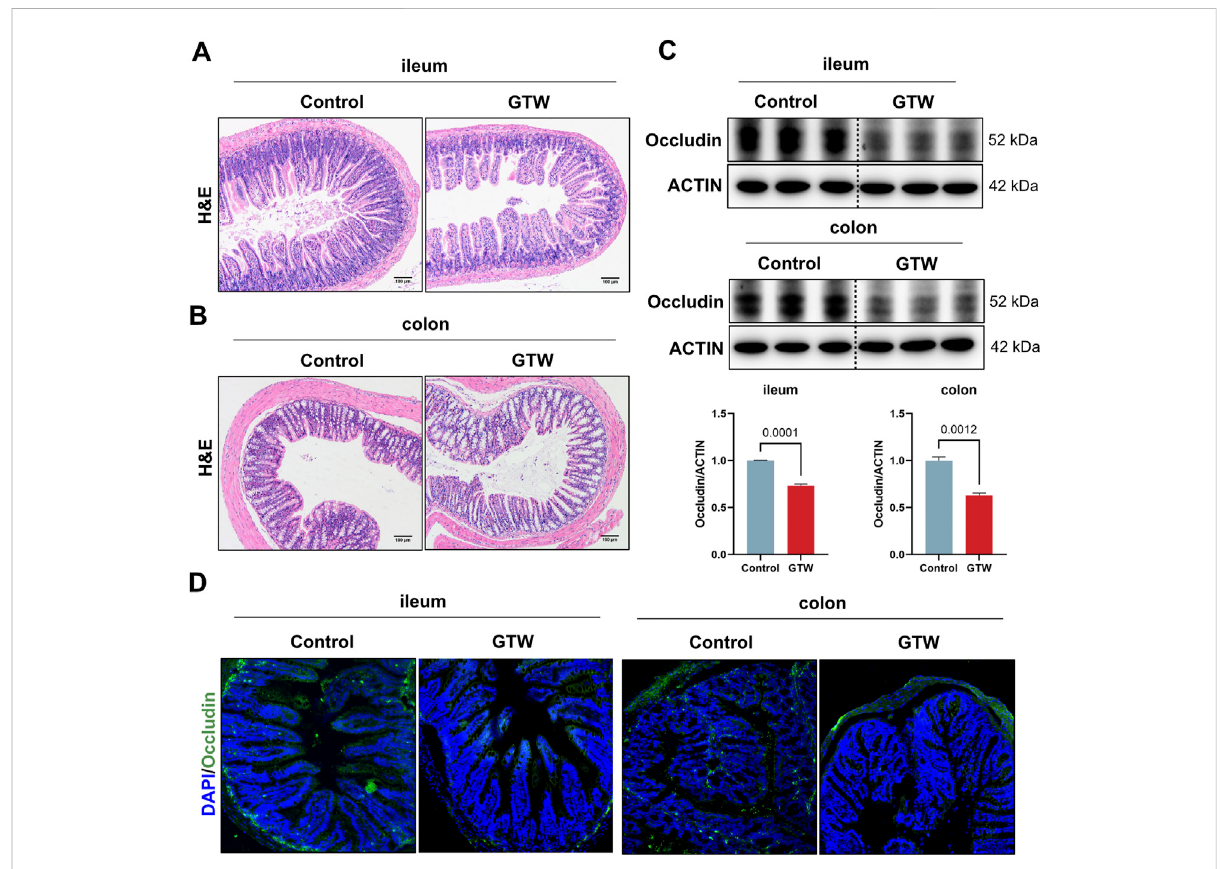
FIGURE 6 The effects of GTW on intestinal barrier integrity. (A,B) Representative H&E staining images of ileum and colon tissues (scale bar = 100 μ m). (C) The protein levels of occludin in the ileum and colon were determined by western blot ( n = 3). (D) Representative images of immuno fl uorescent staining of occludin (green) in ileum and colon sections (20x). The nuclei were visualized with DAPI (blue). The band density was calculated using ImageJ software. Data are presented as mean ± SEM. p < 0.05 was considered statistically signi fi